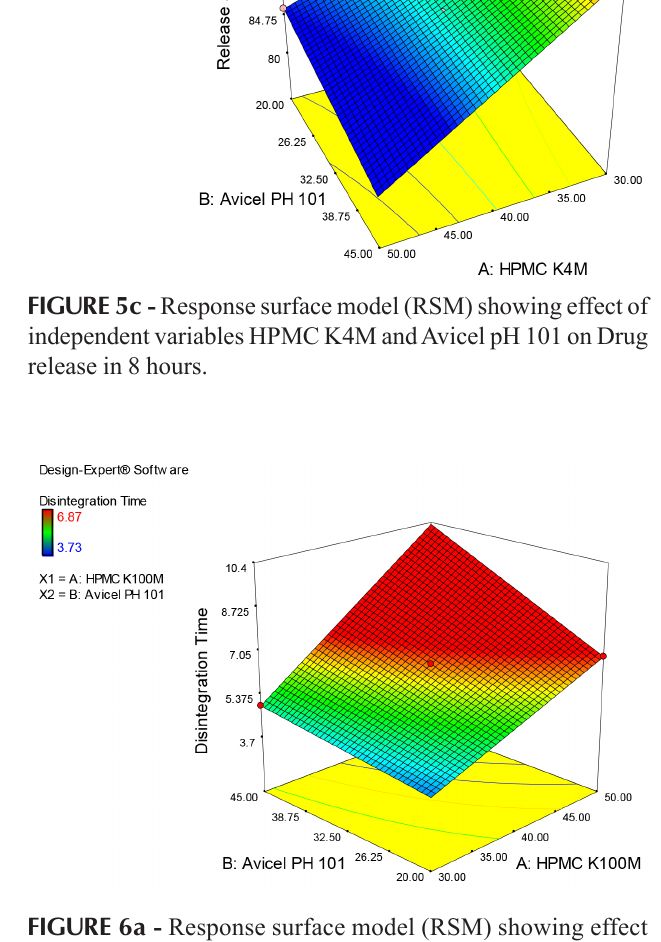
FIGURE 5b - Response surface model (RSM) showing effect of independent variables HPMC K4M and Avicel pH 101 on responses Drug release in 2 hours.